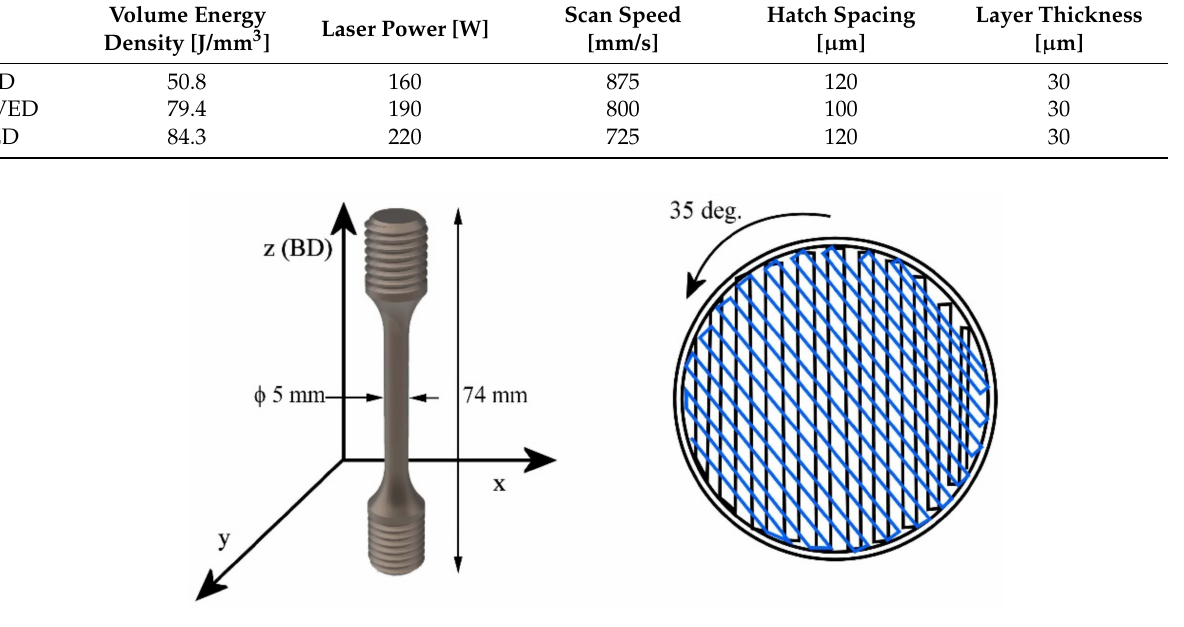
Figure 1. Schematic of building direction, tensile specimen, and build hatching plan. Laser scan track was rotated 35 degrees after each